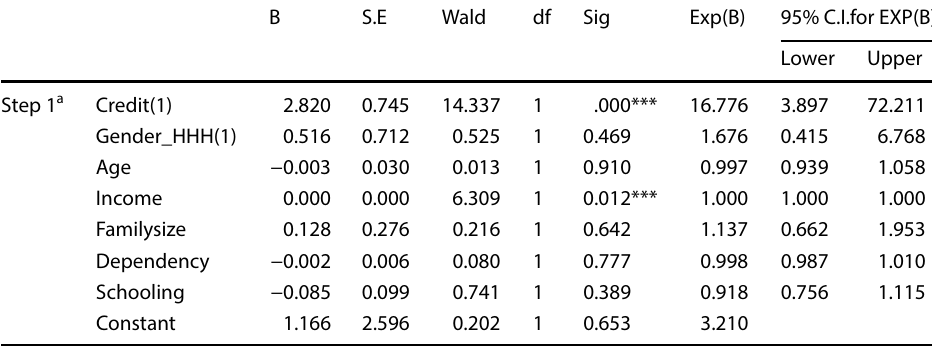
Table 3 Logistic regression of solar energy technology